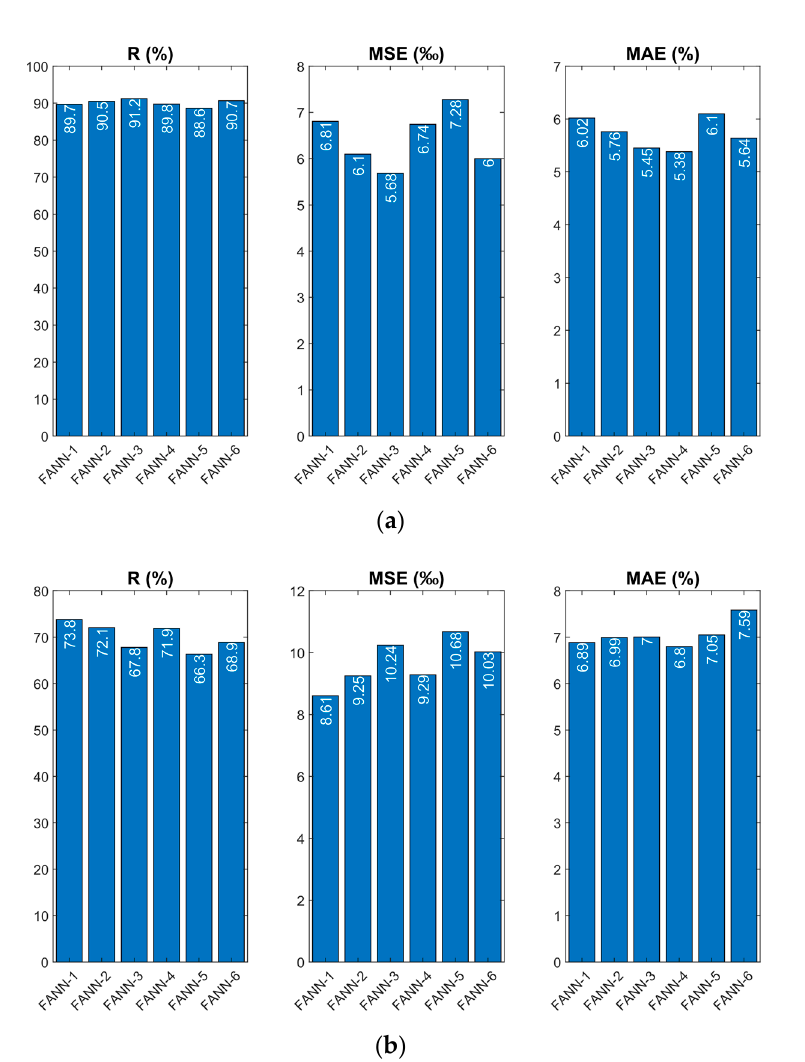
Figure 4. Performance of the various ANN models for the case of cylinders: ( a ) strength models (FANN); ( b ) strain models (EANN).